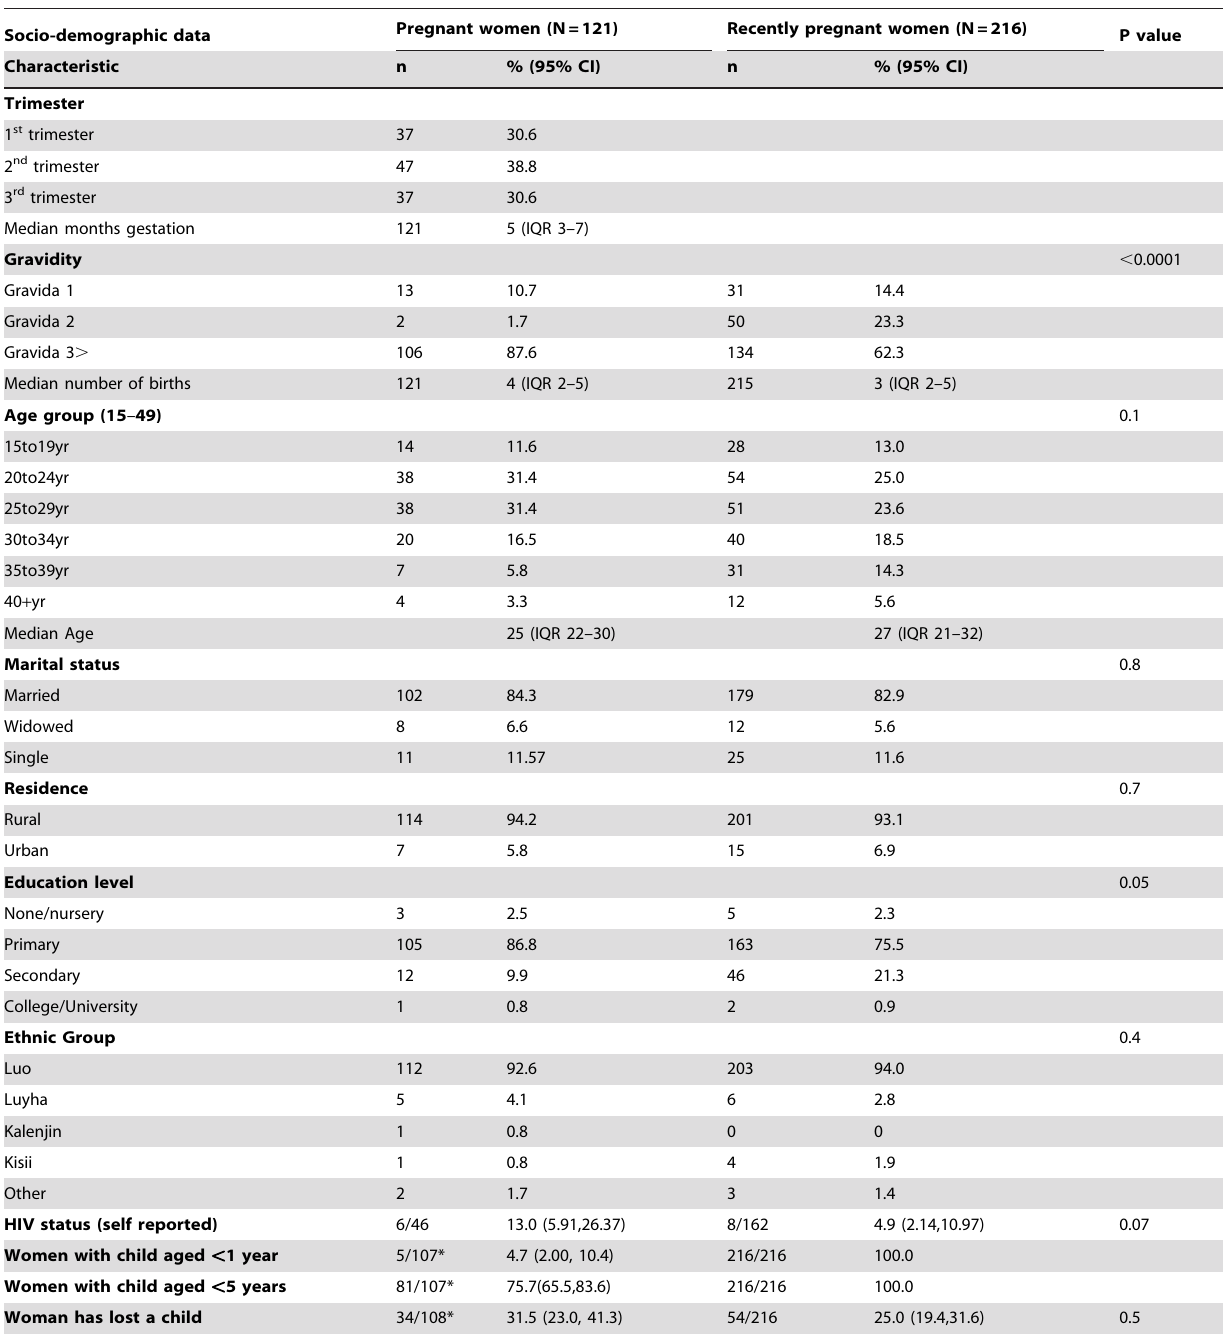
Table 1. Socio-demographic characteristics of the respondents.